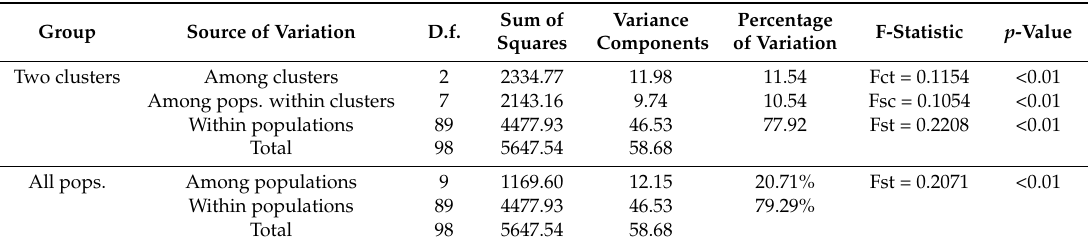
Table 4. Analysis of molecular variance for F. ovina populations.